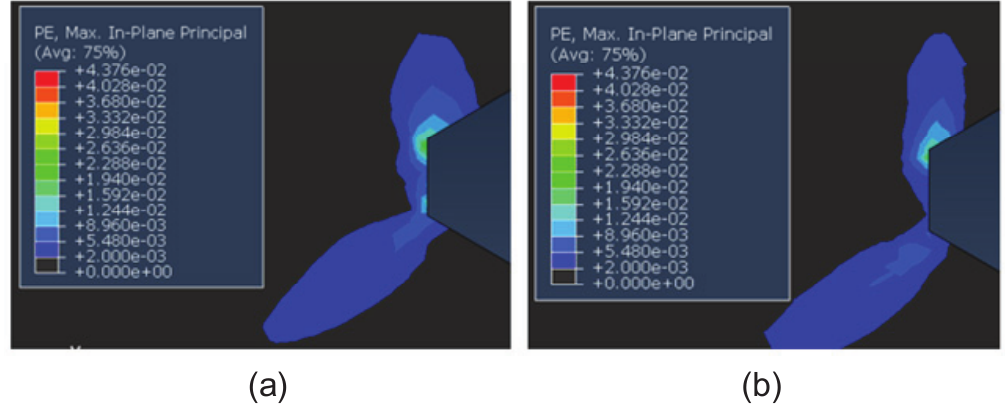
Figure 13. Plastic zone size in the simulations ( a ) without and ( b ) with a near surface hardened layer.